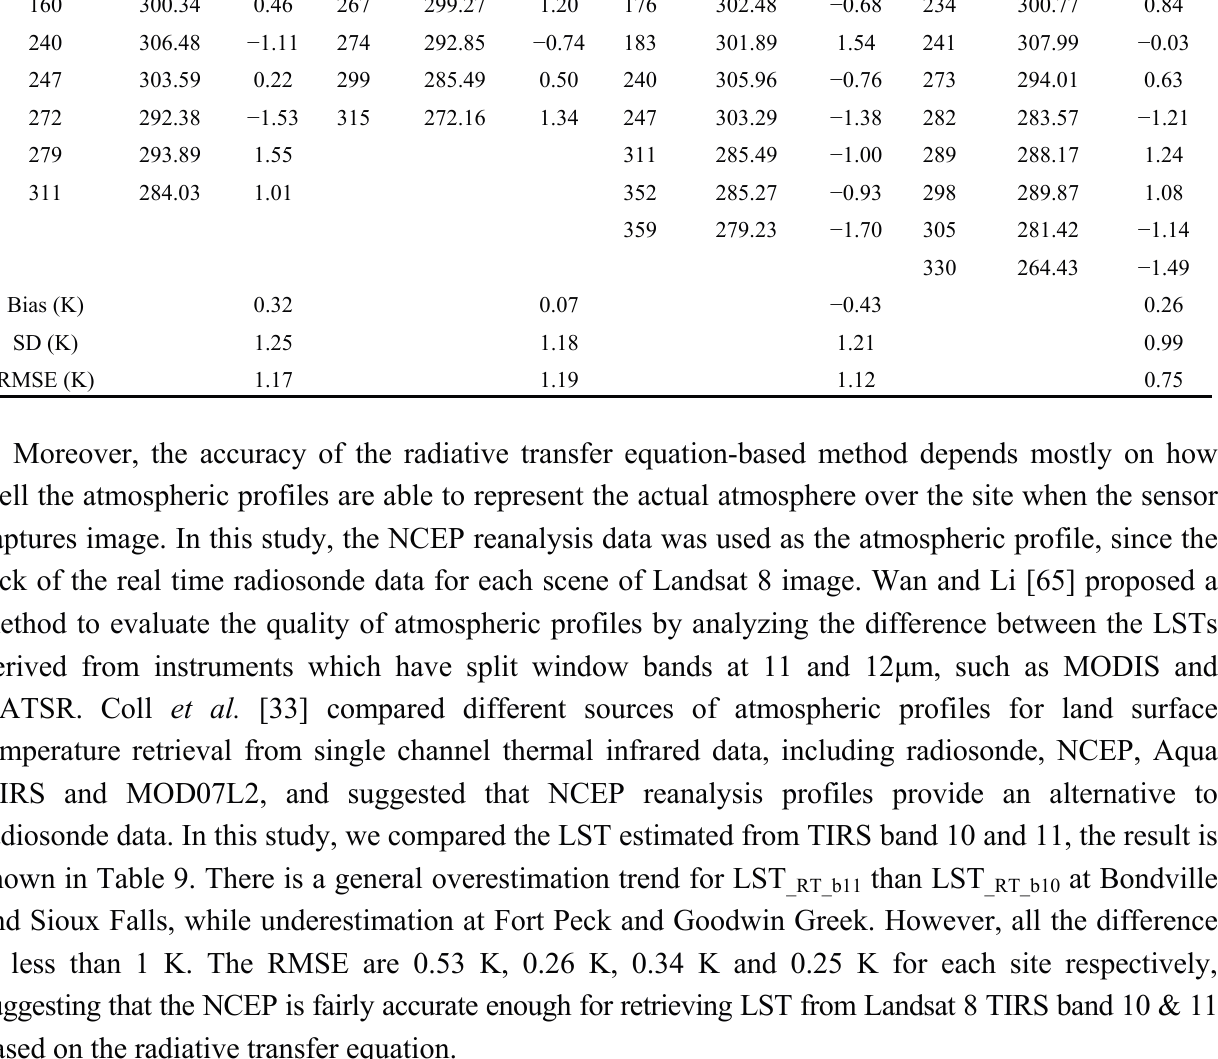
Table 8. Inverted LST (LST TIRS band 11 and the difference ( Δ ) between LST